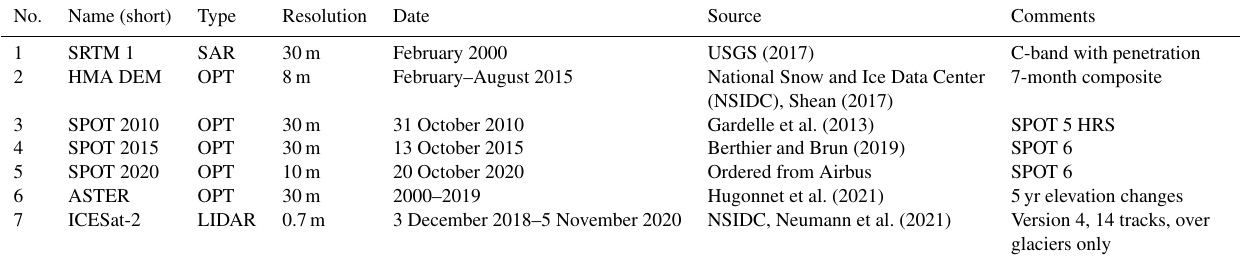
Table 2. Overview of the DEMs used to determine elevation changes in the glaciers in the study region and the additional ICESat-2 dataset.